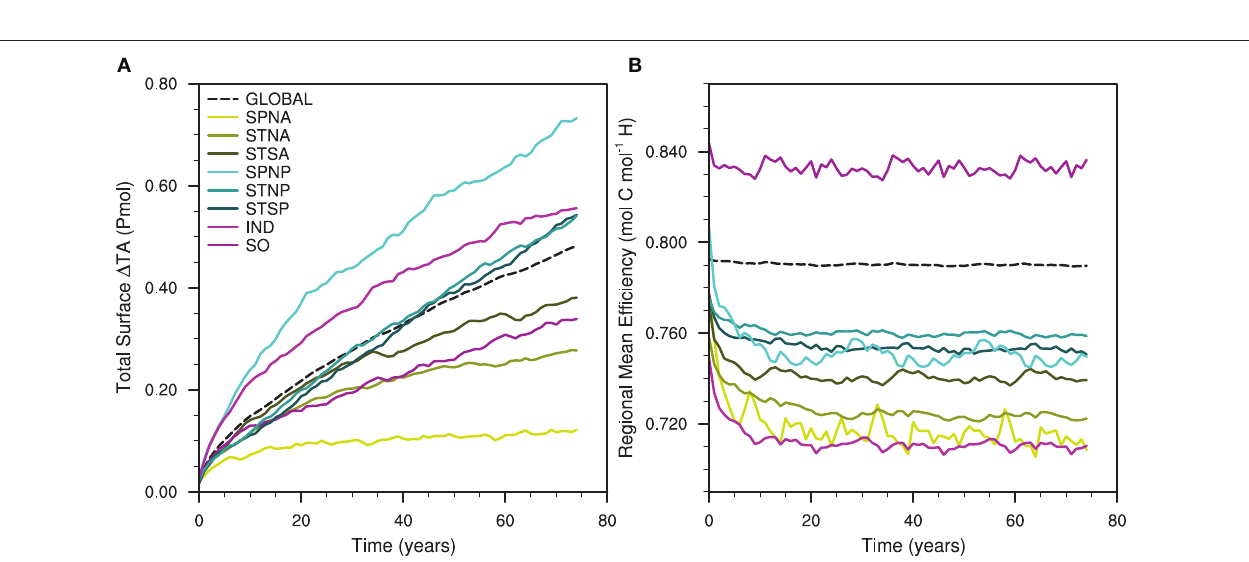
FIGURE 5 | Time series of (A) the total surface total alkalinity anomaly and (B) the carbon-uptake efficiency (Renforth and Henderson, 2017) over time for the global and regional artificial ocean alkalinity experiments.